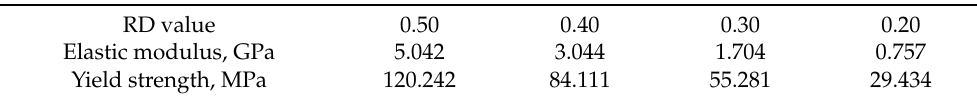
Figure 14. Relative yield-strength-relative density fitted curves of ULSs. Table 1. Mechanical properties of ULSs with different RD values, as predicted from Gibson-Ashby model.